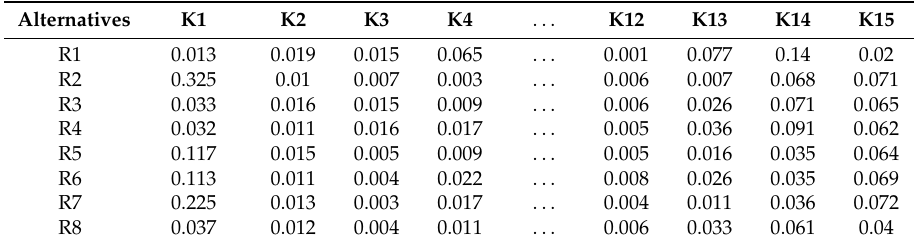
Table 7. The weighted normalized decision matrix.